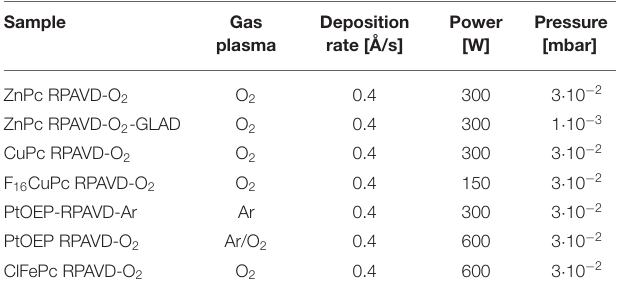
TABLE 1 | Experimental conditions selected for the synthesis of hybrid and metal oxide layers by RPAVD.